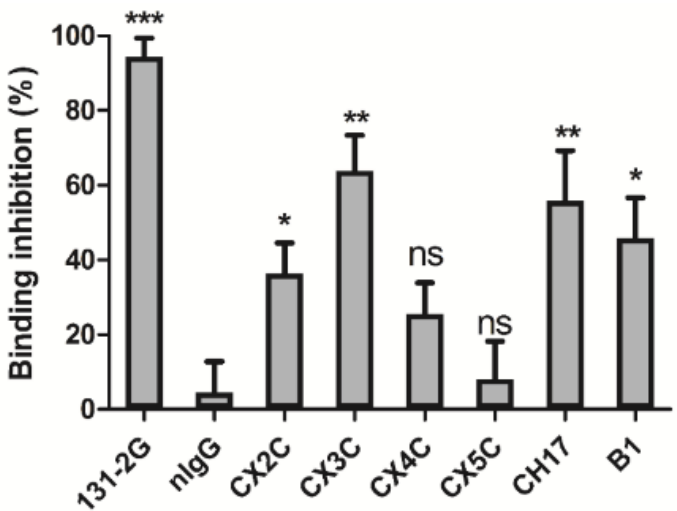
Figure 3. RSV G protein CX3C-CX3CR1 blocking antibody studies. Total IgG was purified from serum derived from mice vaccinated with CX3C peptides and evaluated for the ability to prevent native RSV G protein binding to CX3CR1 expressed on HEK293-CX3CR1 cells. Data are presented as the percent inhibition of RSV G protein binding to HEK293-CX3CR1 cells. Ns, non-significant; * p < 0.05; ** p <0.005; *** p < 0.0005 compared to nIgG (one-way ANOVA, n = 5).